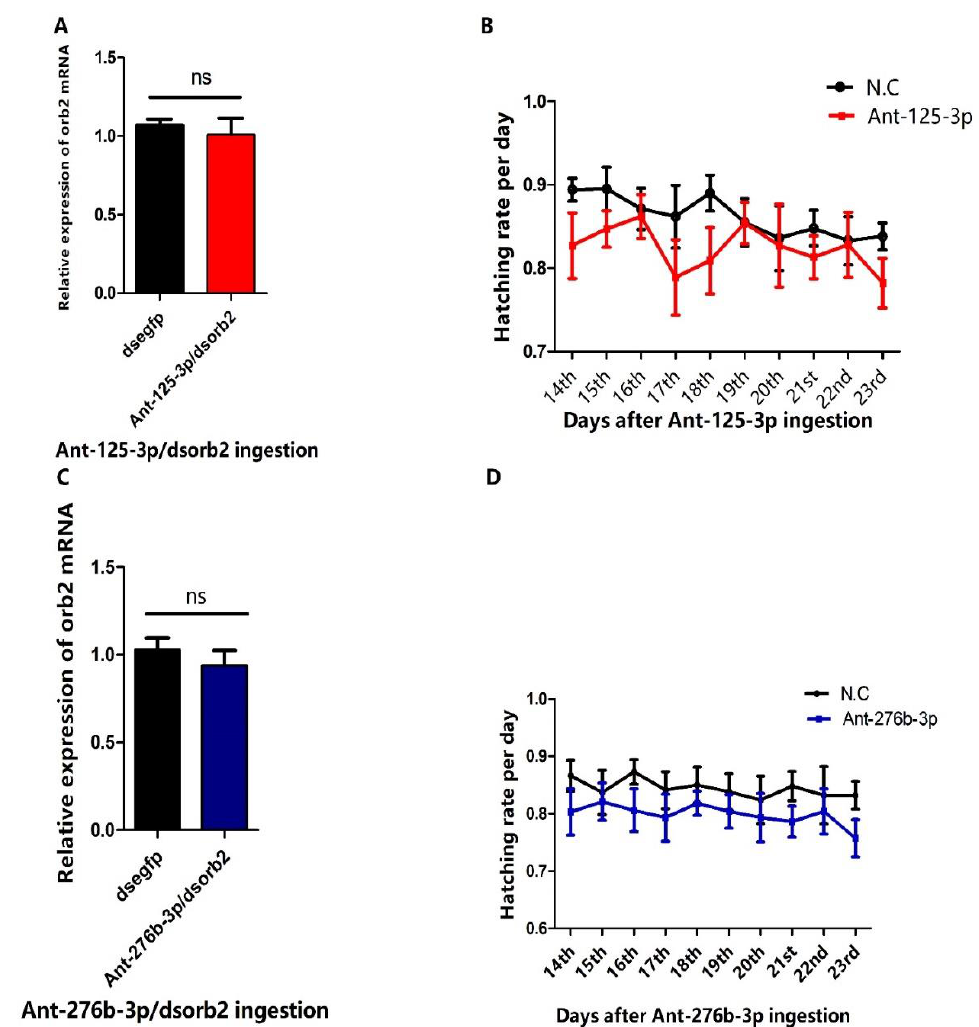
Figure 6. RNAi of antagomir treated individuals rescued the phenotype. ( A ) RNAi of Ant-125-3p treated individuals. ( B ) RNAi of Ant-276b-3p treated individuals. ( C ) Effects of RNAi of Ant-125-3p treated individuals on the reproductive capacity of males of B. dorsalis . ( D ) Effects of RNAi of Ant-276b-3p treated individuals on the reproductive capacity of males of B. dorsalis .